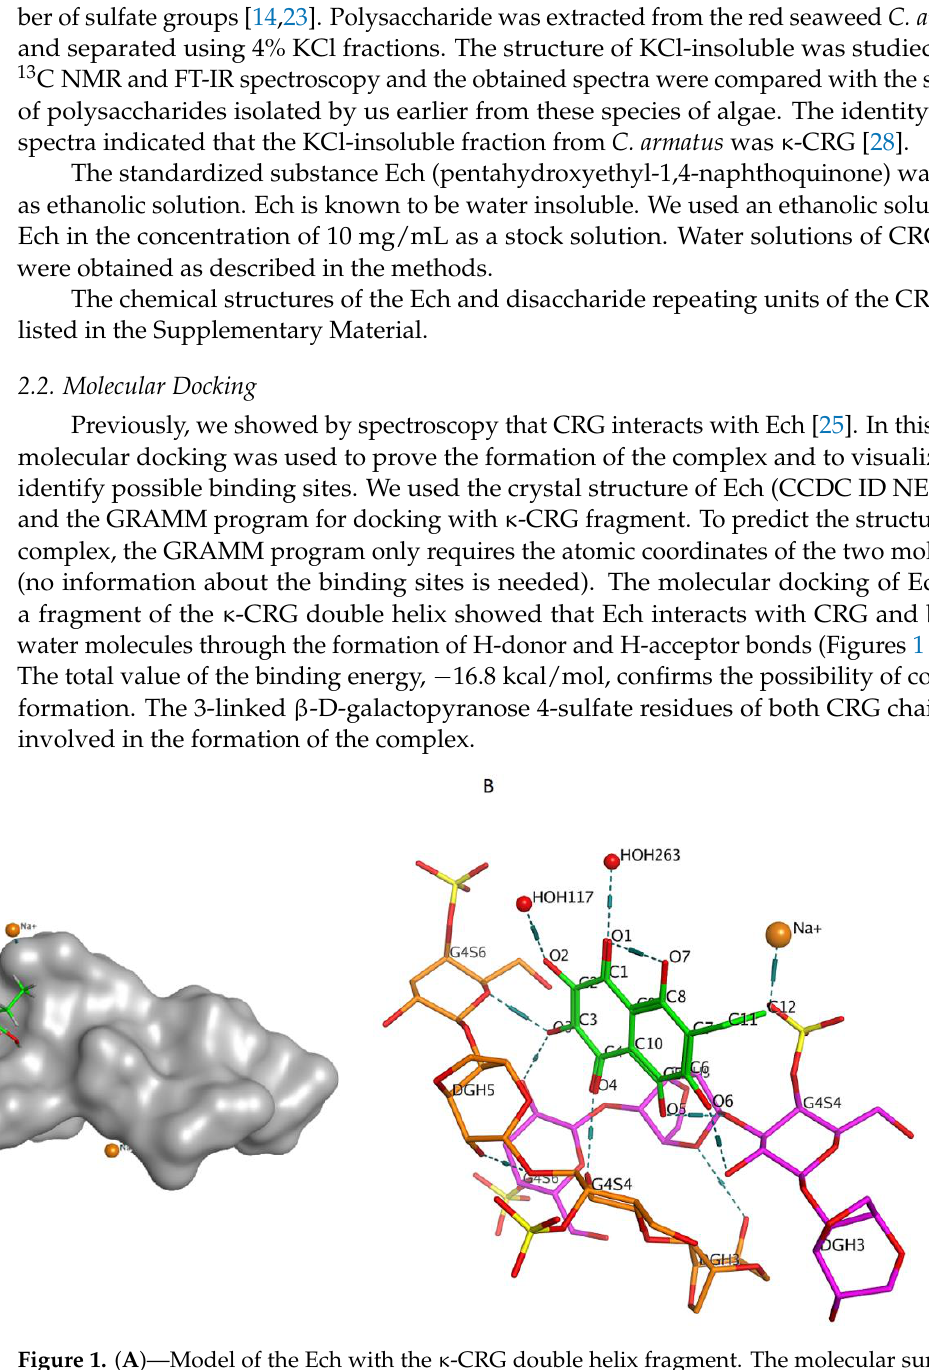
Figure 1. ( A )—Model of the Ech with the κ -CRG double helix fragment. The molecular surface of CRG is shown in grey. The structure of Ech is shown as stick in green. ( B )—Ech binding site with κ -CRG. The structure of κ -CRG double helix residues is shown in orange and pink, Ech is shown as stick in green, water molecules and sodium ion are shown as specific in red and yellow. Hydrogen bonds are shown in dotted lines.